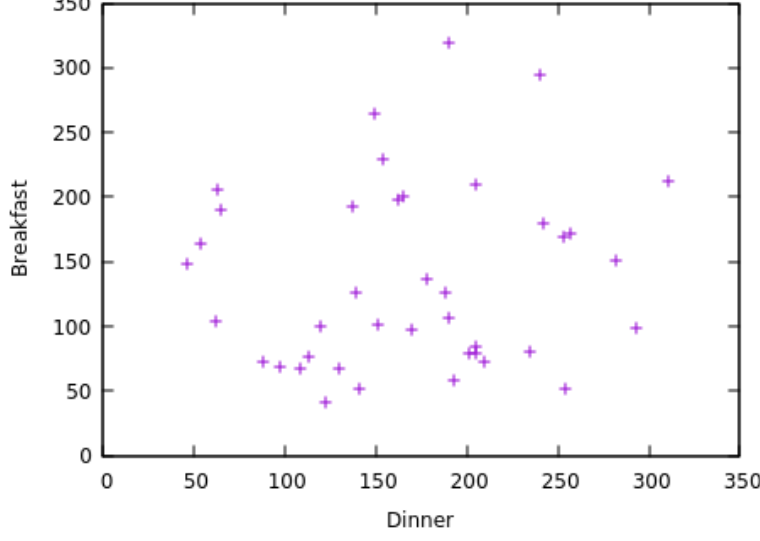
Figure 3. Scatter plot of a measurement at dinner and at breakfast on the next